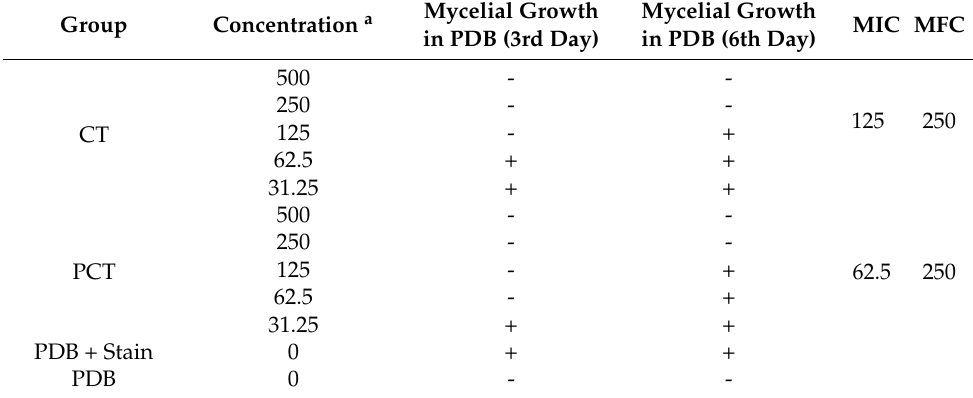
Table 3. MIC and MFC of CT and PCT nanoemulsions against P. italicum